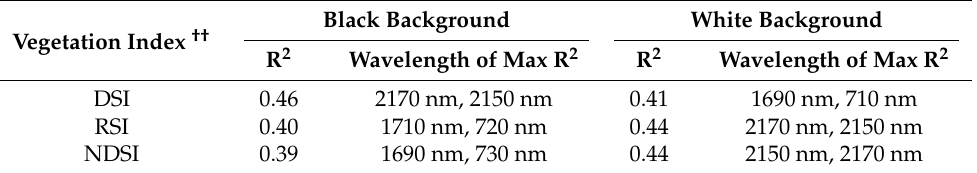
Figure 6. Leaf nitrogen concentrations at the fruit expansion stage in 2014 ( a ) and 2015 ( b ). Every point is an average of 60–80 leaves. Vertical bars represent ± SE.